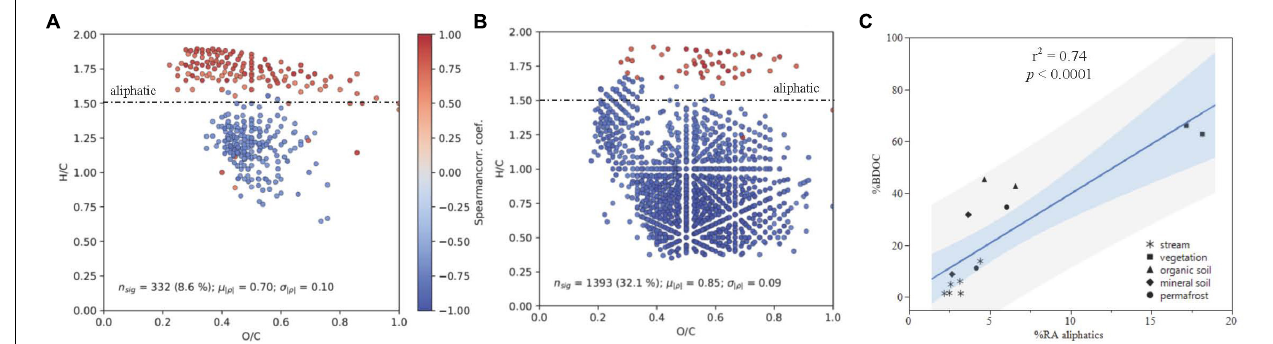
FIGURE 6 | DOM composition as a function of % BDOC plotted in van Krevelen Space for (A) all samples and (B) leachates only, with the boundary for aliphatic formula assignment displayed (formulas with H/C > 1.50). Points represent molecular formulas measured by FT-ICR MS that were present in > 50% of samples and were significantly correlated with % BDOC (p < 0.05). Colors indicate the Spearman rank correlation coefficient between the relative intensity of each molecular formula and % BDOC for its associated DOM sample. Red formulas have a higher relative abundance when the proportion of BDOC is high, while blue formulae have a higher relative abundance when the proportion of BDOC is low. (C) Shows % BDOC as a function of initial ( t = 0) relative abundance of aliphatics (RA ajiphatks ) all DOM types, where the light blue and gray regions indicate the 95% confidence of fit and prediction, respectively. TABLE 4 | Reported p -values from Student’s t tests to determine significant (a) priming and (b) nutrient effects in streams and leachates. One-way ANOVA with Student’s t Spring streams Fall streams Vegetation Organic soil Mineral soil Permafrost n = 60 n = 30 n = 30 n = 30 n = 30 n =